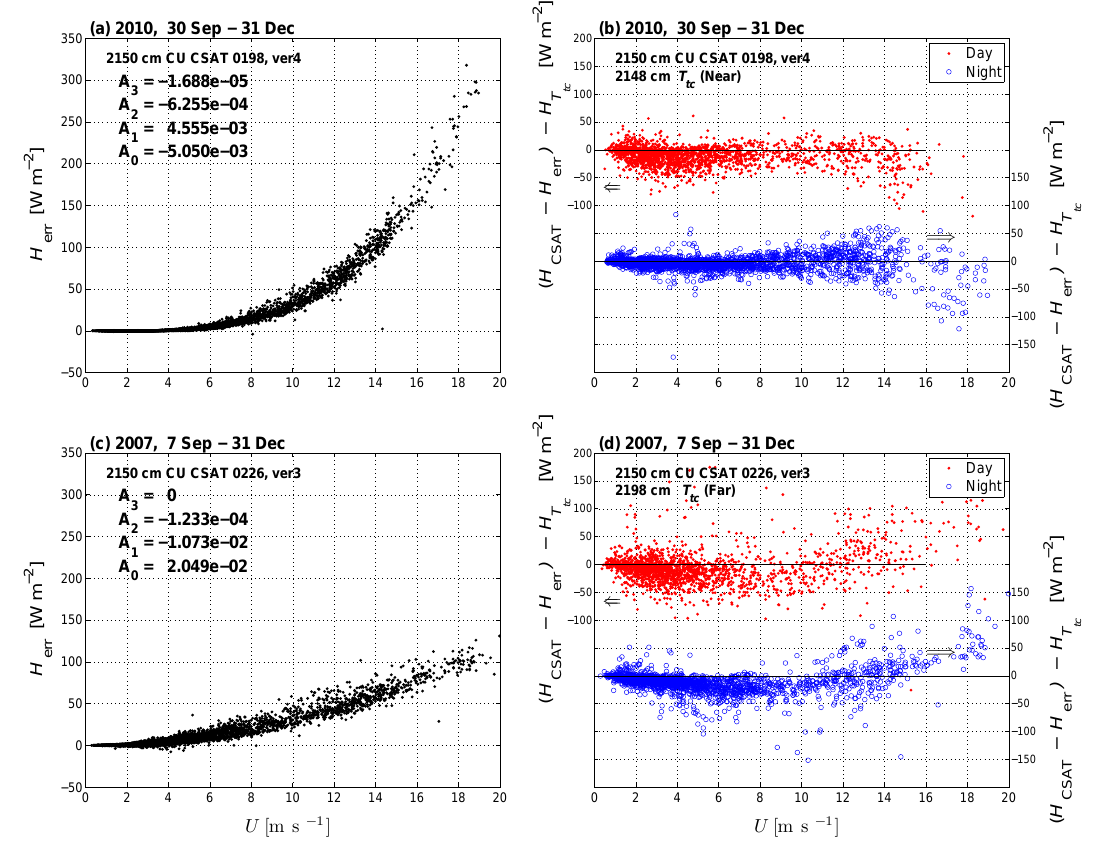
Fig. 10. The (a, c) H CSAT sensible heat flux error ( H err ) determined following Eq. (9) and (b, d) ( H CSAT − H err ) − H T the 21.5m horizontal wind speed U for a ver4 (upper panels) and ver3 (lower panels) CSAT. In (a, c) , the coefficients A 3 – A 0 are determined from a fit of T air s − T asp versus the wind speed. The difference shown in (b) and (d) can be compared to H CSAT − H T and e, respectively. See the Fig. 2 caption for other